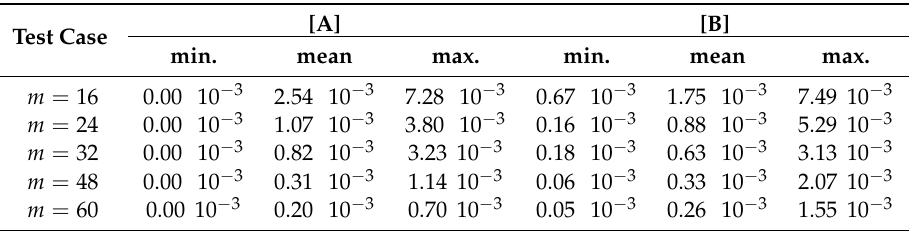
Table 3. Relative error of the Galerkin RB